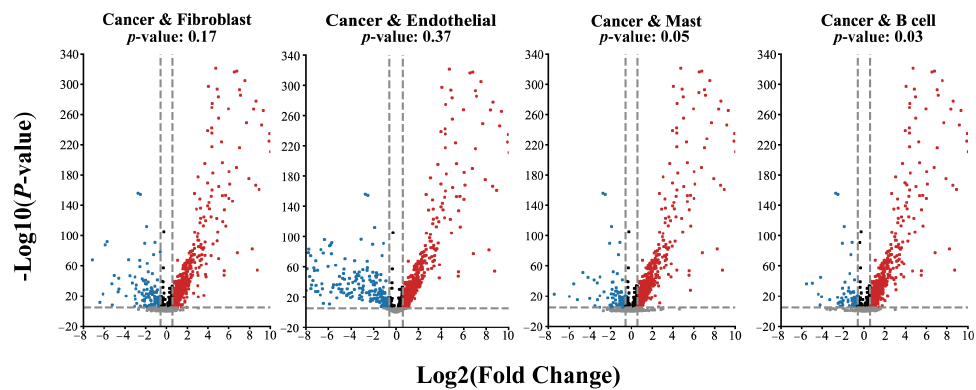
Figure 4. The divergence of gene expression on different cell types. The red dot represents the genes with a positive correlation, the blue dot represents the genes with a negative correlation, and the black dot represents the gene with no difference in expression level. The grey dot represents the gene below the threshold.